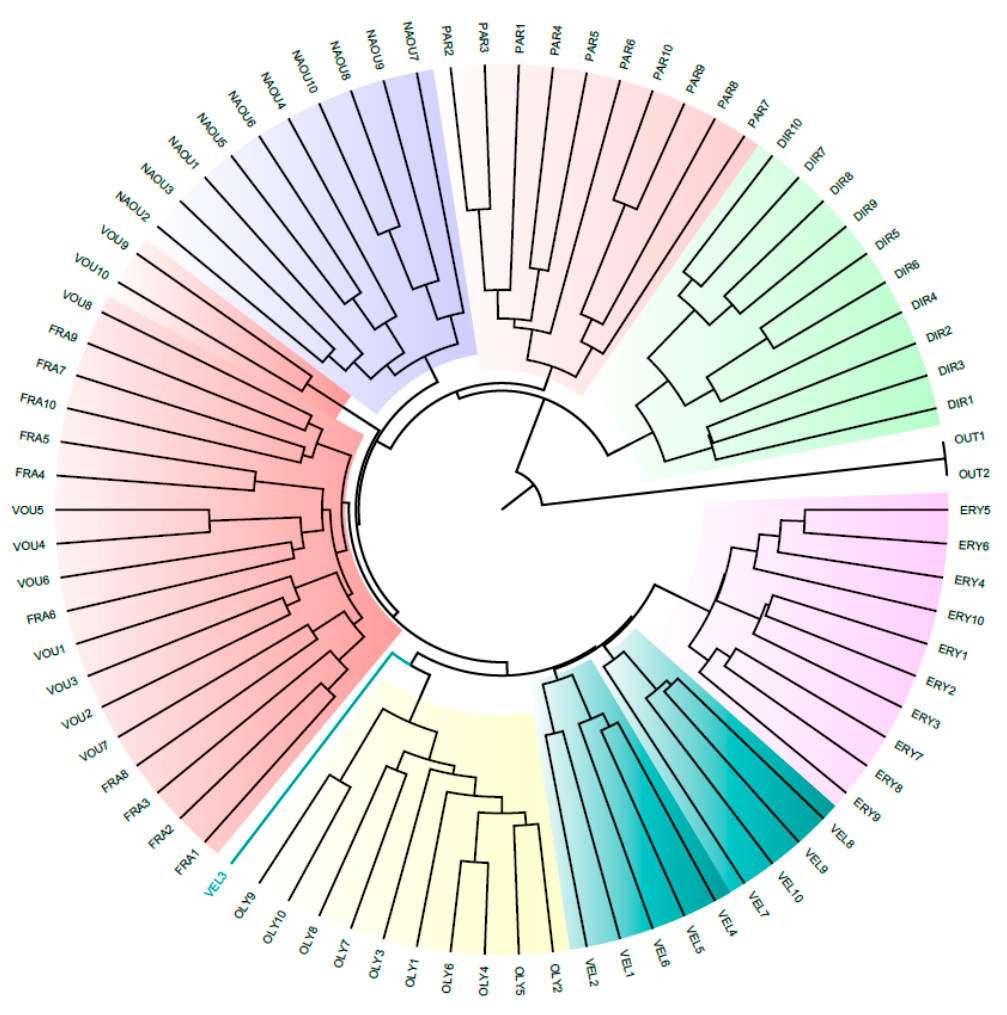
Figure 3. UPGMA dendrogram based on Jaccard’s coefficient illustrating the genetic similarities of 80 Helleborus odorus subsp. cyclophyllus individuals from different populations.